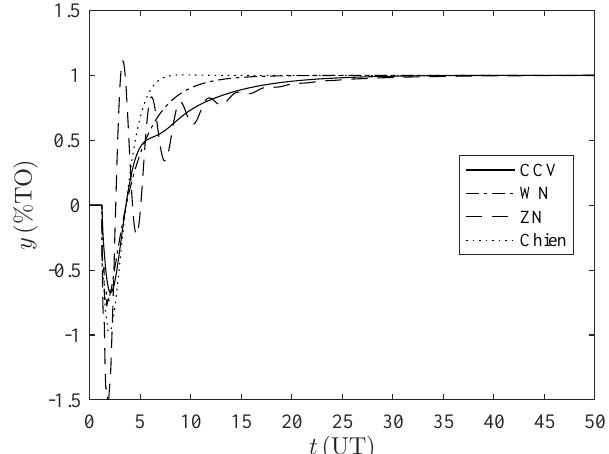
Figure A1. Time response disturbance rejection for the set P 1 . %TO: percentage of transmitter output, UT: units of time.